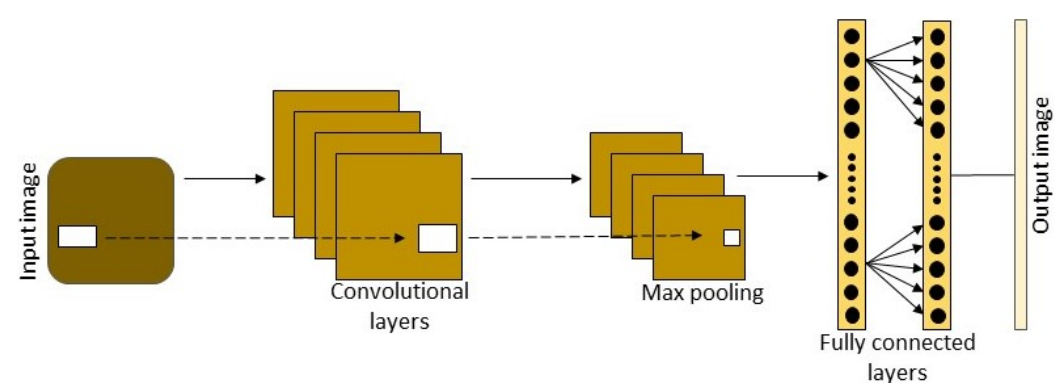
Figure 3. General architecture of the patch ‐ level CNNs model.